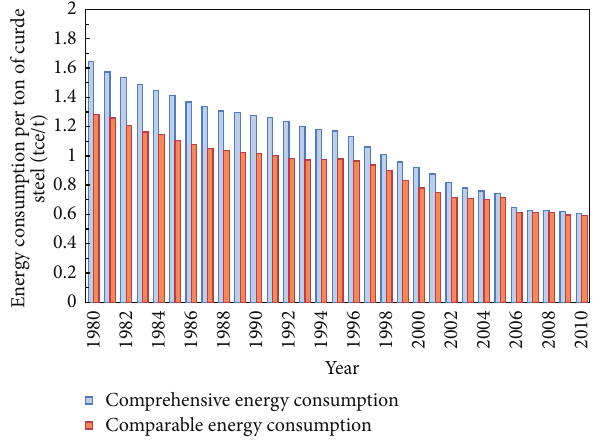
Figure 2: Changes in CSI energy